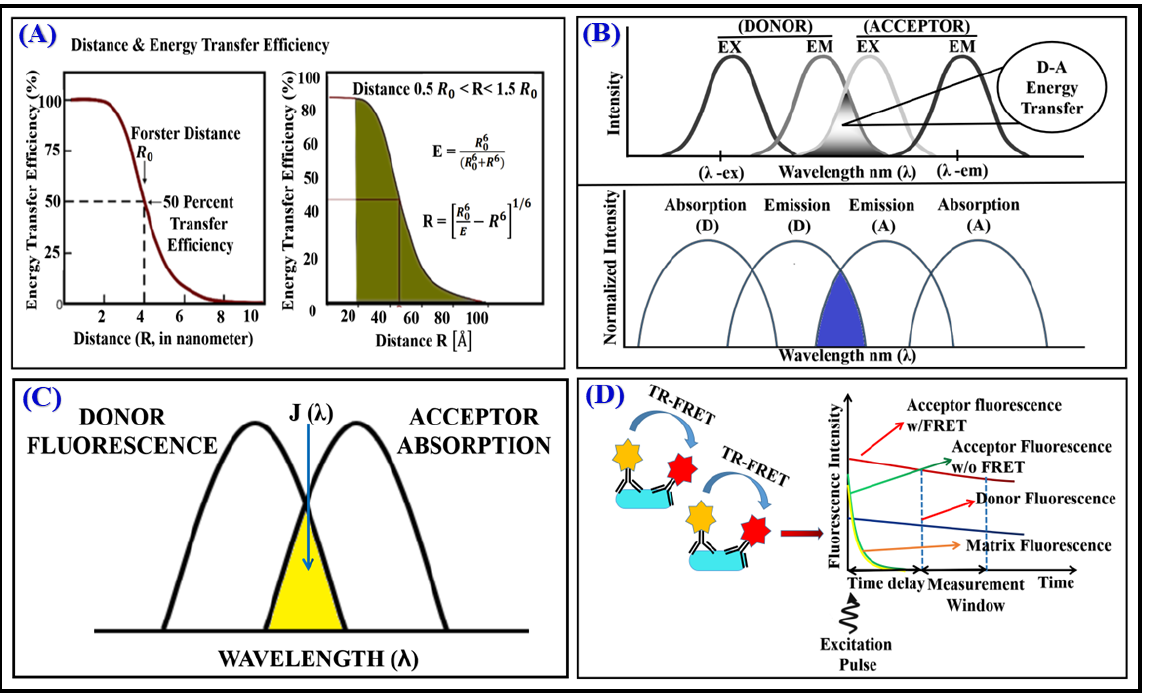
Figure 3. ( A , B ) Overlap integral for donor fluorescence and acceptor absorption. ( C ) Transfer efficiency. ( D ) TR - FRET.